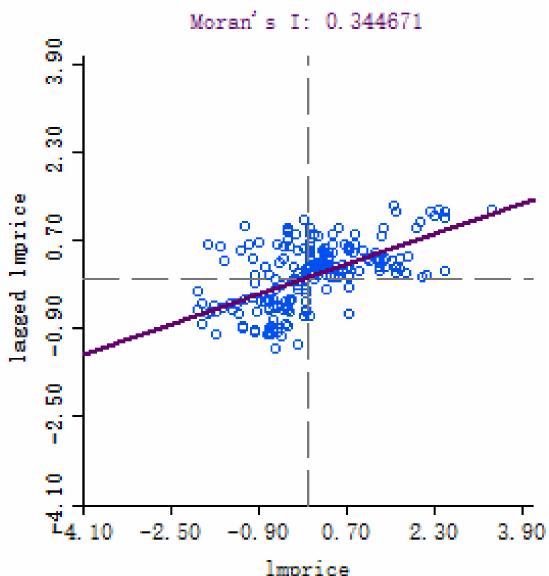
Figure 4. LISA scatter plot of commercial land prices in the main urban area of Hangzhou from 2006 to 2015.